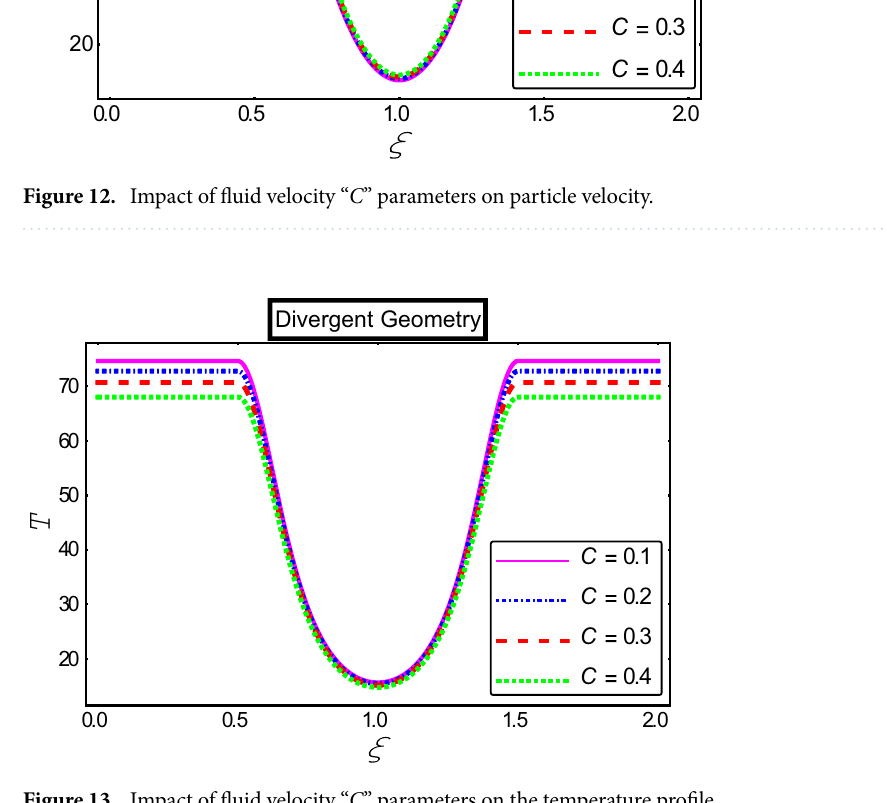
Figure 13. Impact of fluid velocity “ C ” parameters on the temperature